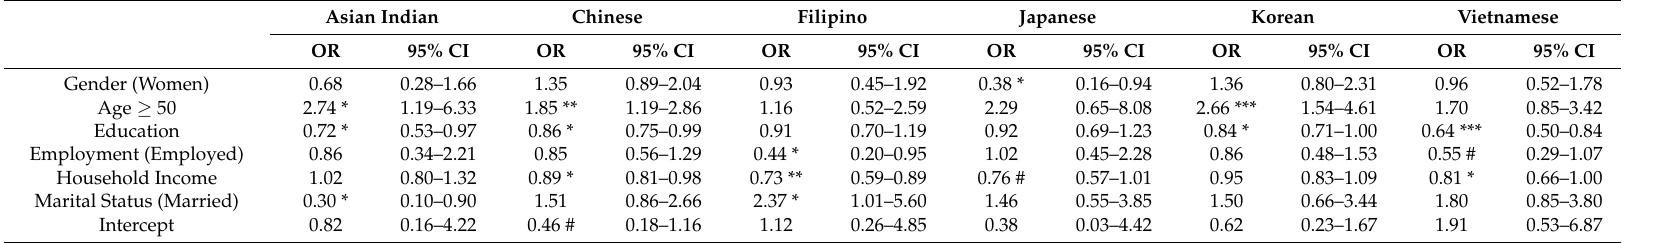
Table 3. Factors associated with poor physical self-rated health (SRH) across ethnic